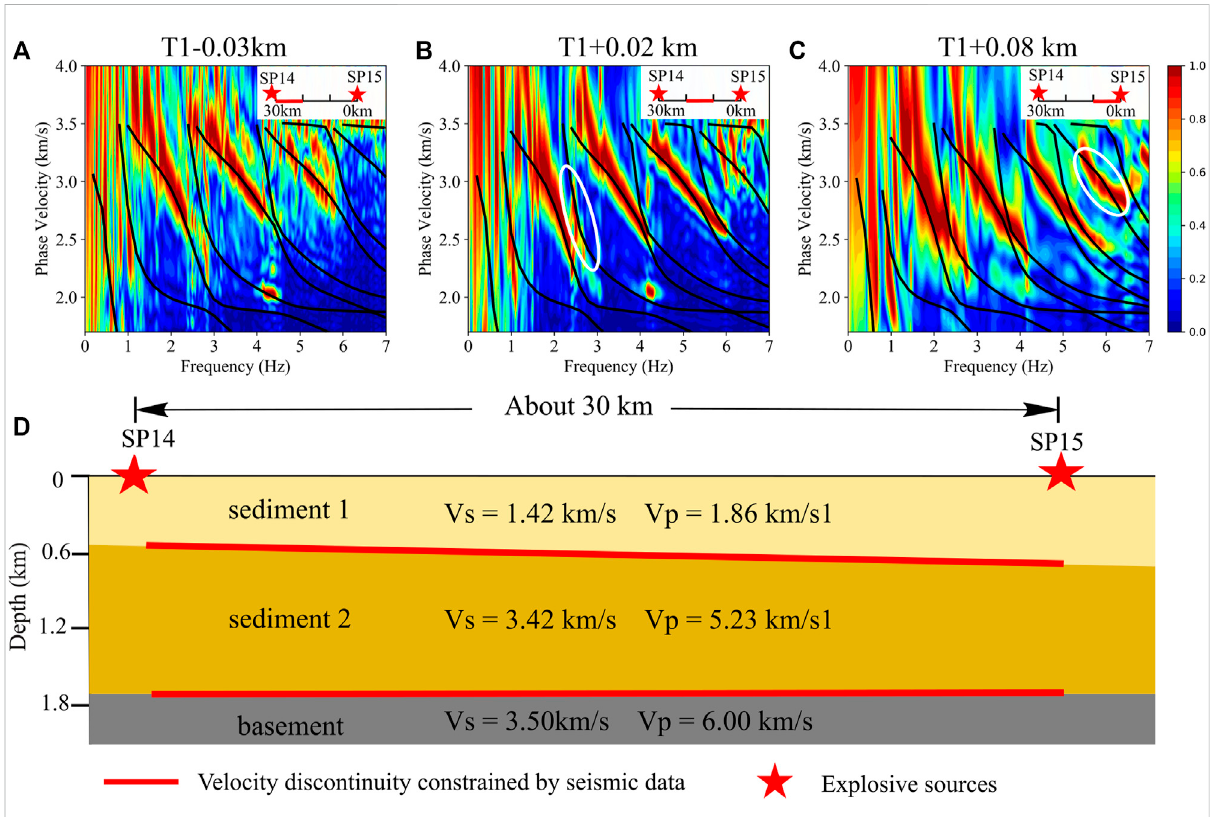
FIGURE 9 The analysis of the F-J spectrograms extracted from the 10-km-long seismic record sections. In the upper right corners of (A – C) , the red stars representthesource,andtheF-Jspectrogramsareextractedfromtheseismicdataontheredlines.Inthetitlesof (A – C) ,T1representsthe fi rstlayer thicknessofthebest fi ttingmodel(model4)inTable2.TheF-Jspectrogramsin (A) , (B) , (C) areextractedfromthe20 – 30 kmoffset,10 – 20 kmoffset, and0 – 10 kmoffsetofSP15seismicdatarespectively.ThedispersioncurvesineachF-Jspectrogramwerecalculatedby (A) themodelobtained by subtracting 0.03 km from the fi rst layer thickness of model 4; (B) the model obtained by adding 0.02 km to the fi rst layer thickness of model four; and (C) the model obtained by adding 0.08 km to the fi rst layer thickness of model 4. (D) The 2D minimum-structure model constructed by combining the three 1D models of (A – C)